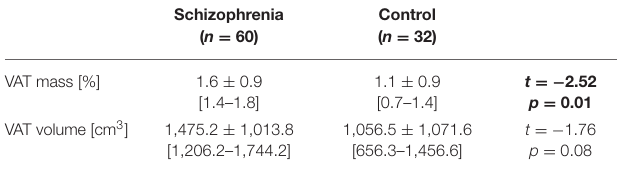
TABLE 1 | Summary of clinical data.